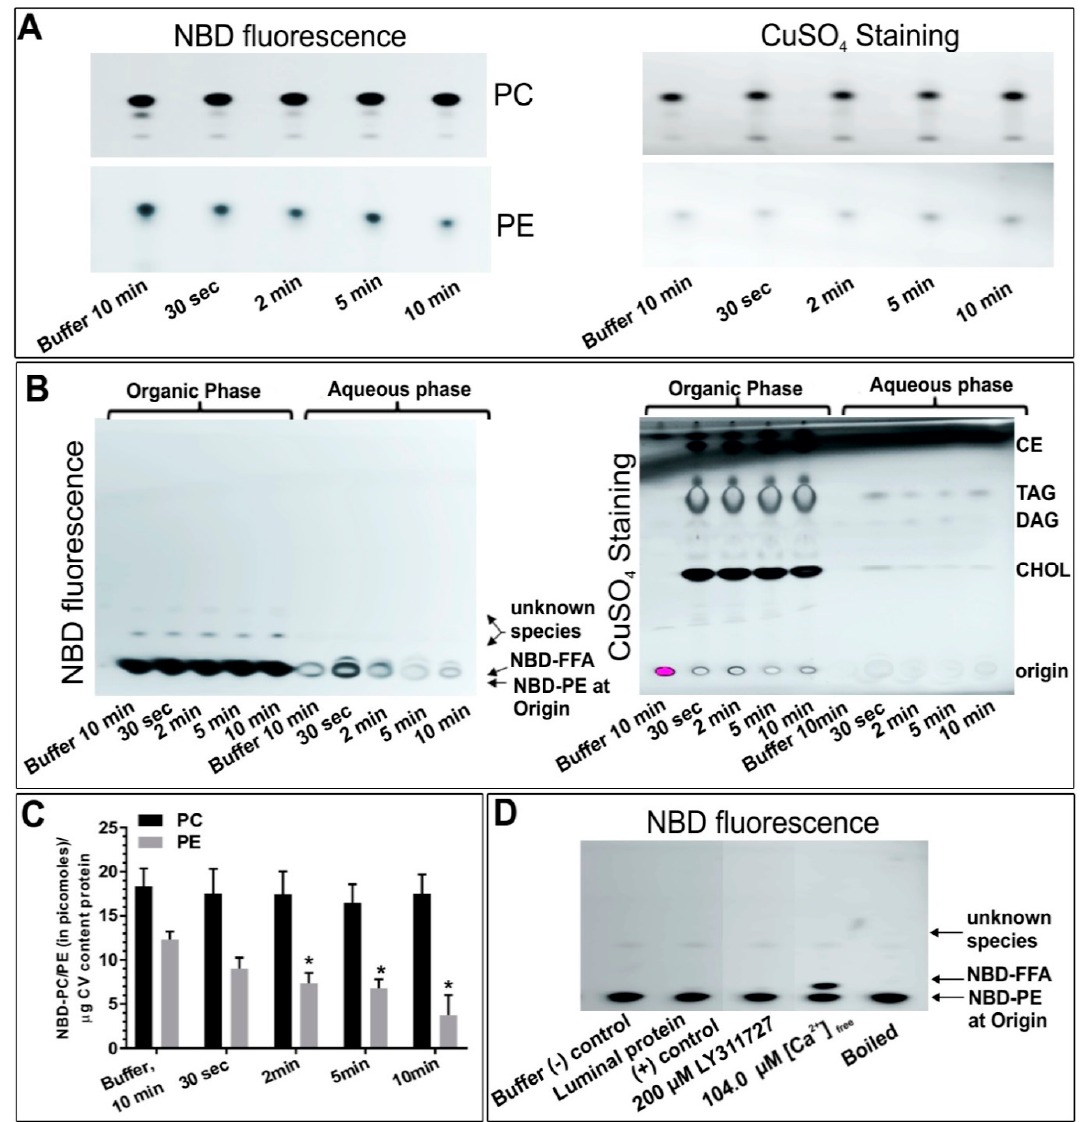
Figure 5. ( A ) Time-dependent decrease in NBD-PE and no change in NBD-PC, when incubated with isolated CV luminal proteins, n = 3; ( B ) Detection of NBD-FFA generated from NBD-PE, when incubated with CV luminal proteins; n = 2–3. After incubations, activity was stopped by adding 0.2 µL HCl, total lipids isolated, resulting organic and aqueous phases retained, dried and resolved. ( C ) Bar graph summarizing the changes in NBD-PC and -PE, indicating the presence of CV luminal PLA 2 with high catalytic activity for PE. ( D ) Effect of LY311727, increased [Ca 2+ ] free and boiling on luminal PLA 2 activity assessed by incubating isolated CV luminal proteins with NBD-PE; n = 3. ( p -value, * < 0.05 indicates difference relative to the control). The chromatograms in A were resolved using a standard phospholipid protocol and in B and D using an established protocol for neutral lipids [56]. Note: Left panels in A and B show NBD fluorescence and the right panels show same section of the chromatogram after charring with CuSO 4 [56]. The lanes shown in D are grouped together from the same chromatogram following removal of lanes not associated with this study.